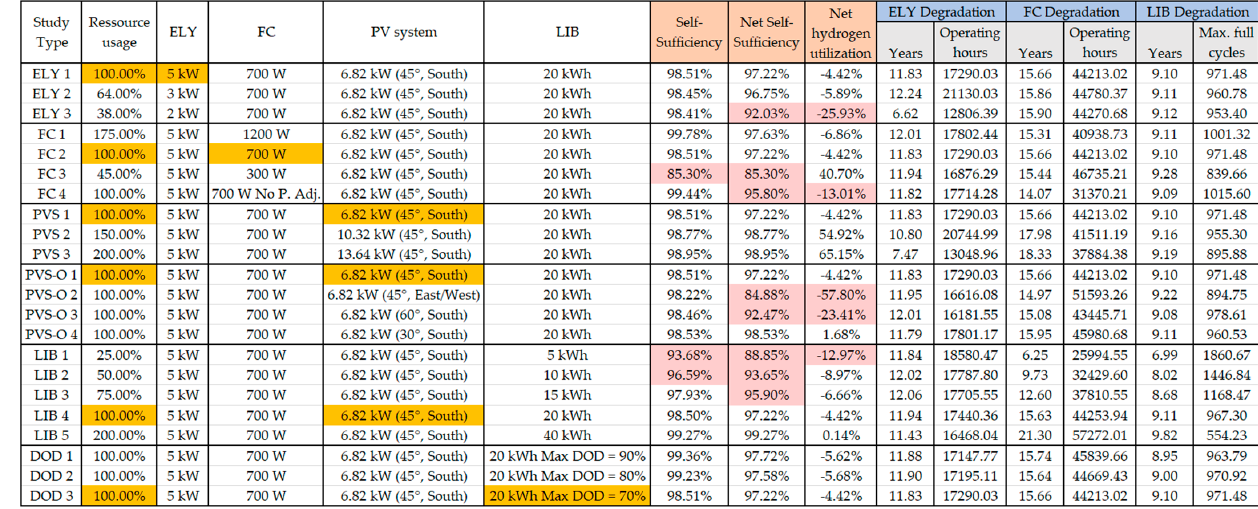
Figure 17. Lifetime Comparison between all parameter studies (configurations with less self ‐ sufficiency under 97% are marked red; resource usage is based on the number of cells (for ELY and FC), number of modules (PV) or capacity (LIB)). The base configuration is marked orange; the net self ‐ sufficiency describes the self ‐ sufficiency when an 𝐻 (cid:2870) deficit (negative net hydrogen utilization) is compensated by the energy grid (calculation: 𝐻𝐻𝑉 ∙ ∆𝐻 (cid:2870) (cid:4670)𝑘𝑔(cid:4671) ∙ 𝜂 (cid:3007)(cid:3004),(cid:3028)(cid:3049)(cid:3034). ) higher heating value * Delta kg * average efficiency); The net hydrogen utilization describes how much 𝐻 (cid:2870) is required compared to the 𝐻 (cid:2870) produced (minus: higher 𝐻 (cid:2870) demand than production).